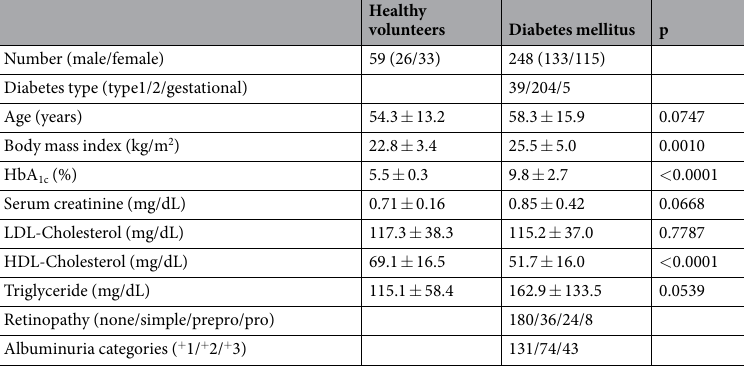
Table 1. Characteristics of study participants. HDL, high-density lipoprotein; LDL, low-density lipoprotein;